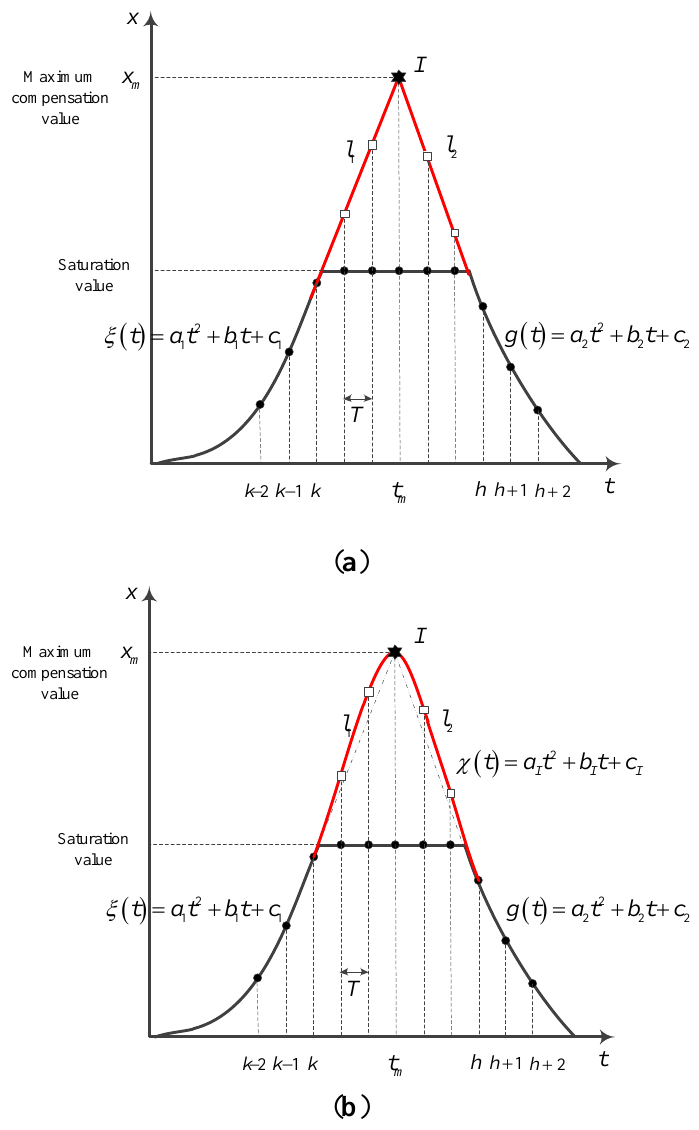
Figure 4. Estimation of  using geometric form. ( a ) Triangle approximation; ( b ) Quadratic